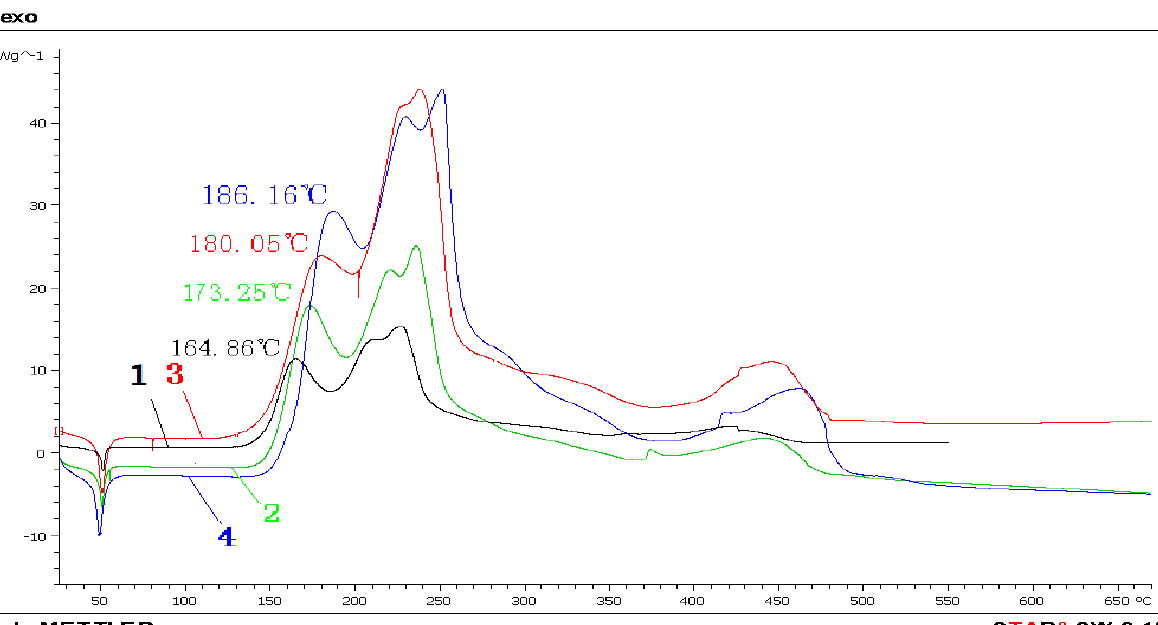
Figure 5. The DSC curves of pretreated paraffin in O 2 with different heating